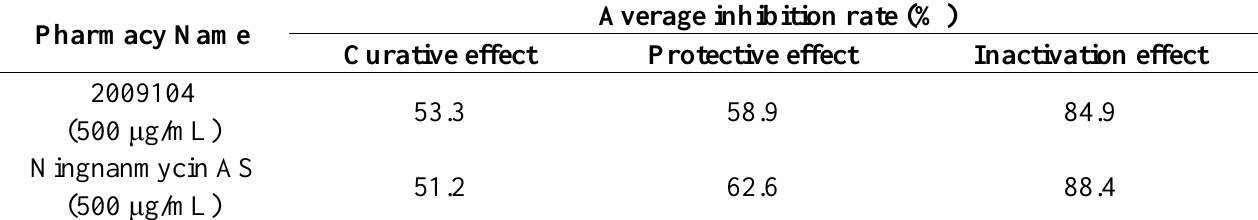
Table 1. The result of curative, protective and inactivation efficacies of compound 2009104 against